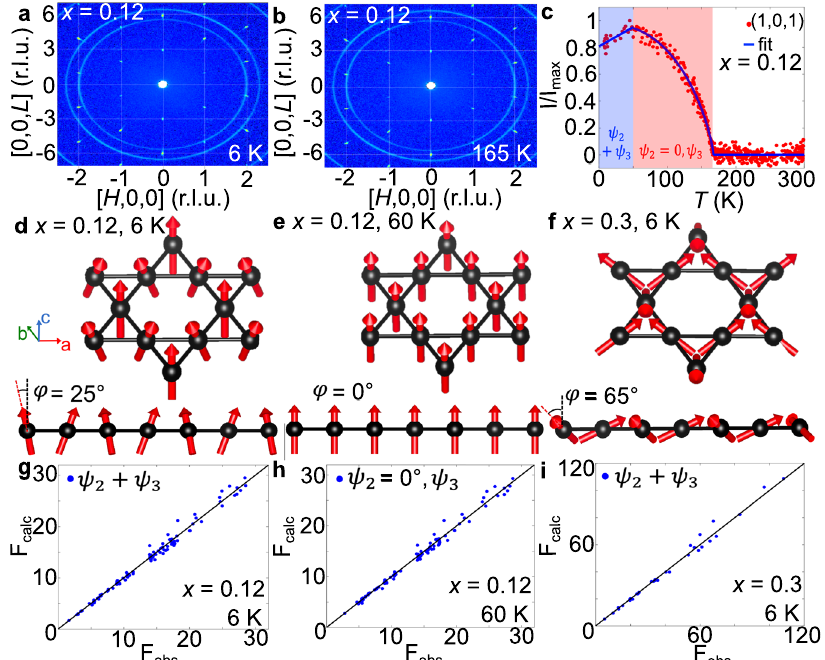
Fig. 2 Neutron diffraction results and magnetic structures of Co 3 Sn 2- x In x S 2 . Maps of magnetic peaks in reciprocal space from neutron diffraction of x = 0.12 sample at ( a ) 6 K and ( b ) 165 K. c Temperature dependence of the (1,0,1) magnetic Bragg peak intensity. Re fi ned magnetic structures in x = 0.12 crystals at ( d ) 6 K and ( e ) 60 K and ( f ) x = 0.3 at 6 K. Comparison of measured (F obs ) and calculated (F calc ) integrated intensities from the re fi nement in the ψ 2 þ ψ 3 magnetically ordered phases shown in ( d – f ) in x = 0.12 crystals at ( g ) T = 6 K and ( h ) 60 K and ( i ) x = 0.3 at 6 K. The overall R values = 3.79, 3.63, and 4.04% for x = 0.12 at ( g ) T = 6 K, ( h ) 60 K, and ( i ) x = 0.3 at 6 K, respectively. The overall R values best fi t the data for the